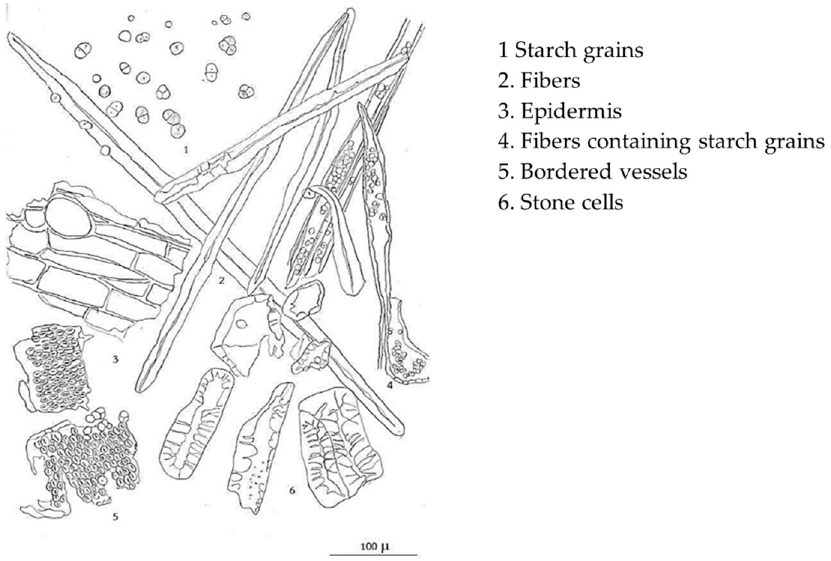
Figure 2. Microscopic character of powder of L. martabanica (root).